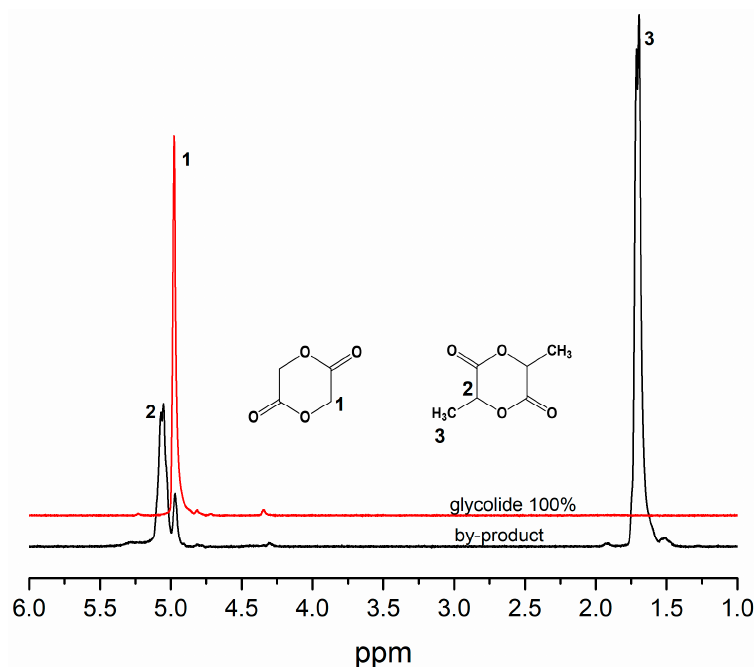
Figure 1. 1 H NMR analysis of by-products collected during synthesis of poly(lactide- co -glycolide) (PLGA) copolymers and pure glycolide.